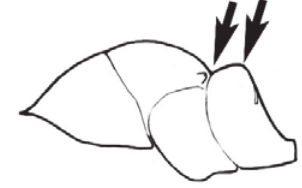
In profile, propodeum of minor and major worker protuberant and strongly truncate, with elevated dorsal surface which is much shorter than declivitous surface; larger ants (HW of minor worker 0.65 mm ≥, HW of major worker 1.25 mm ≥); metanotal groove characteristically a deep V-shaped notch; most workers with long, flexuous setae but these may be short and bristly (northern NT, QLD and WA) ( JDM 470 ) (Fig. 35a–g) ..................................